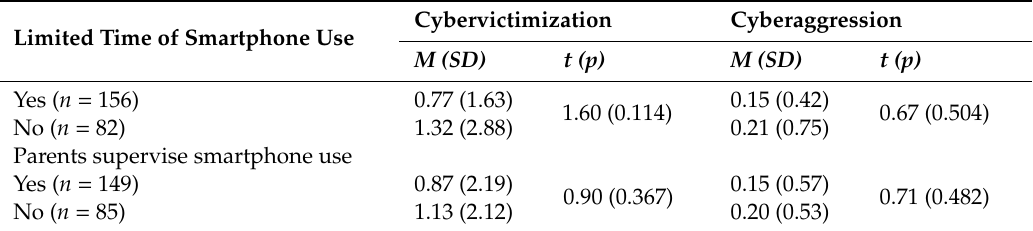
Table 6. Comparison of scores on cybervictimization and cyberaggression as a function of frequency of parental control (supervision and time